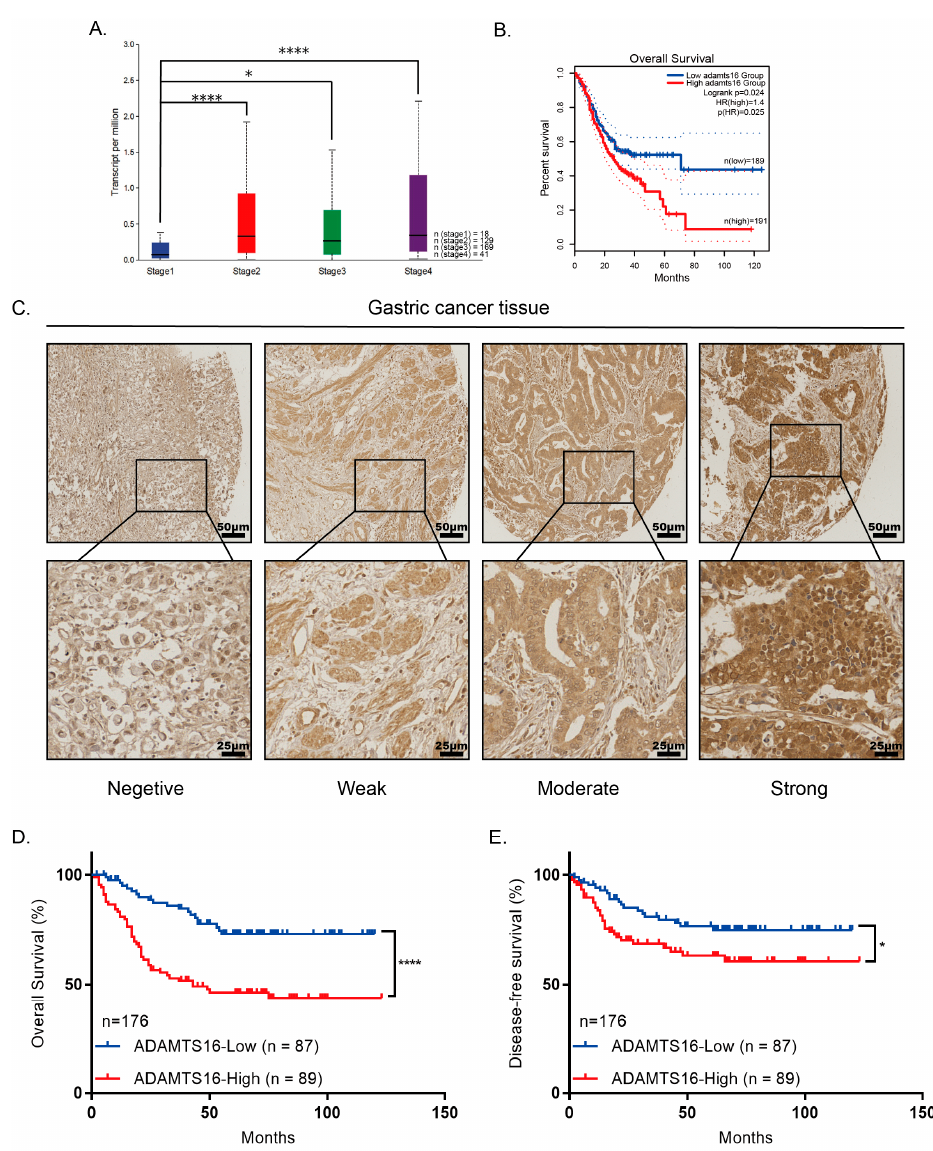
Figure 5. ADAMTS16 is upregulated in gastric cancer (GC) and is associated with a poor prognosis. ( A ) ADAMTS16 mRNA expression in advanced-stage GC tissue was higher than in early-stage GC tissue in TCGA. ( B ) GEPIA2 Kaplan–Meier plot of the effect of ADAMTS16 gene expression on GC patient survival. ( C ) Representative immunohistochemical staining image for ADAMTS16 protein expression level in GC. ( D , E ) Kaplan–Meier survival curves of GC patients on ADAMTS16 expression. Scale bar: 25 µm ( C up), 50 µm ( C down). The data are shown as means ± standard deviations. * p < 0.05, **** p < 0.0001.